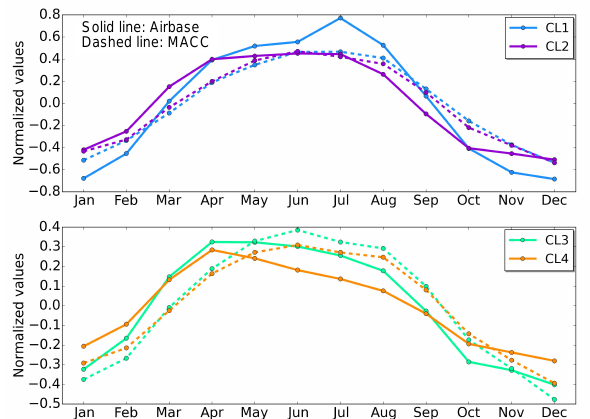
Figure 17. Seasonal cycles of cluster centroids; Airbase vs. MACC, second CA.